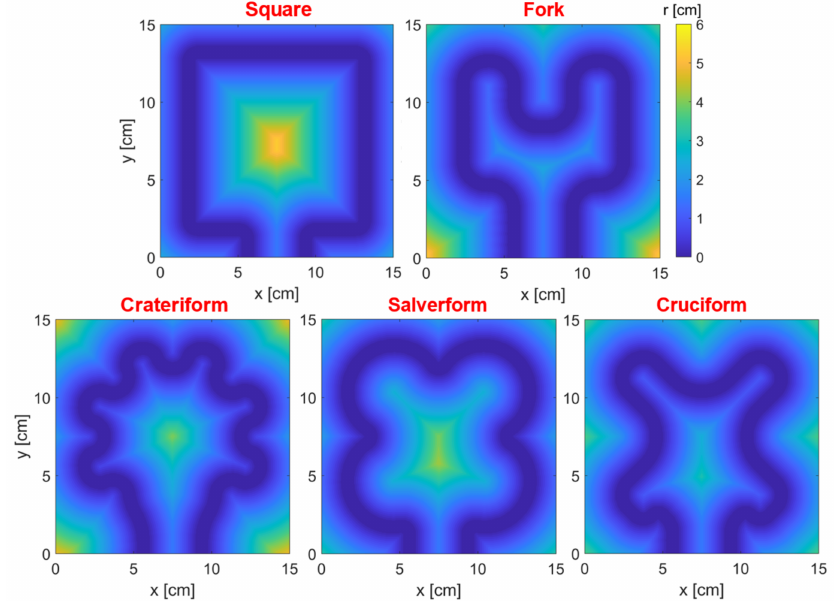
Figure 4. Distribution of minimum distance to the channel for all